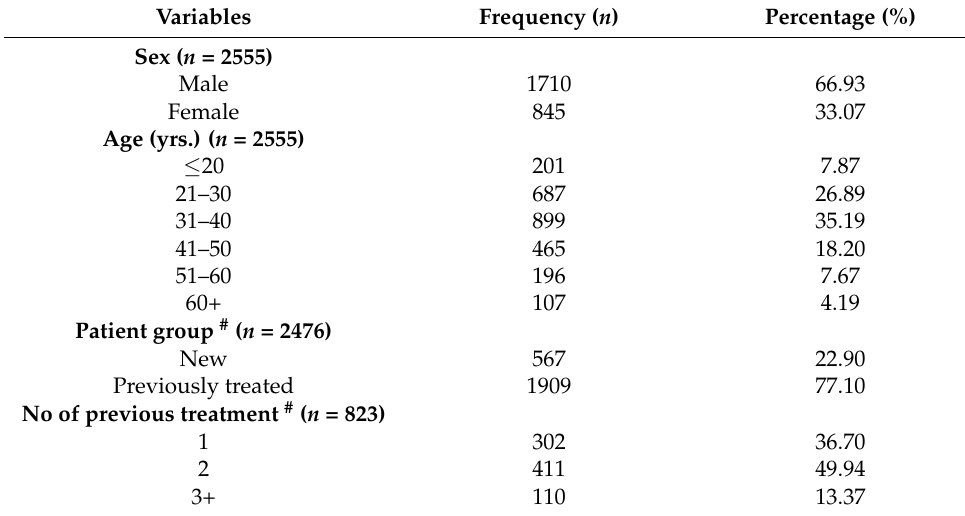
Table 1. Frequency table of the study participants with bacteriologically confirmed DR-TB in Nigeria (2010–2016) ( n = 2555